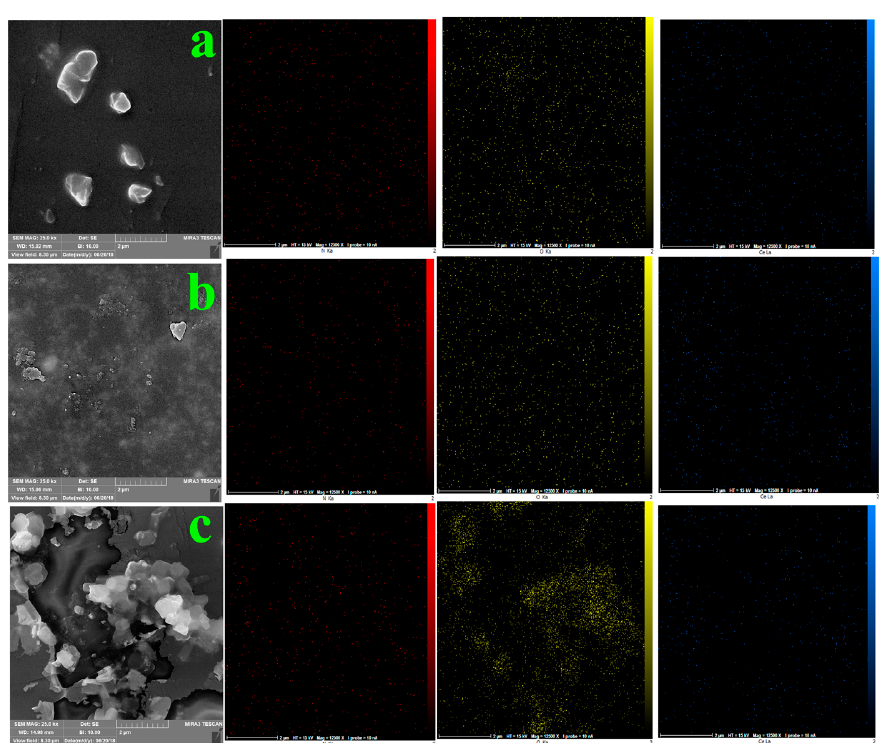
Figure 13. Mapping graphs of NCs samples, ( a ) NC2, ( b ) NC4, and ( c ) NC8. Red for N, yellow for O, and blue for Ce element.